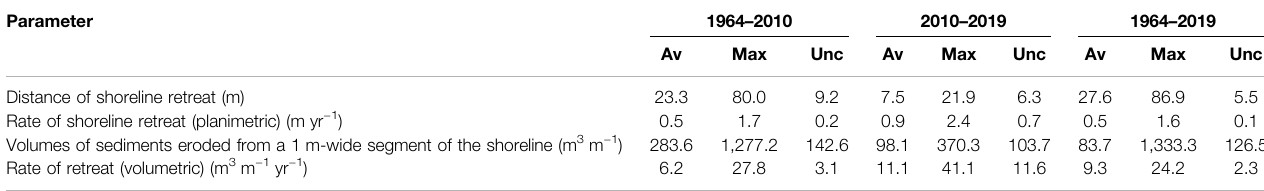
TABLE 1 | Parameters of shoreline retreat for erosional coastal segments of the Gulf of Kruzenstern. Parameter